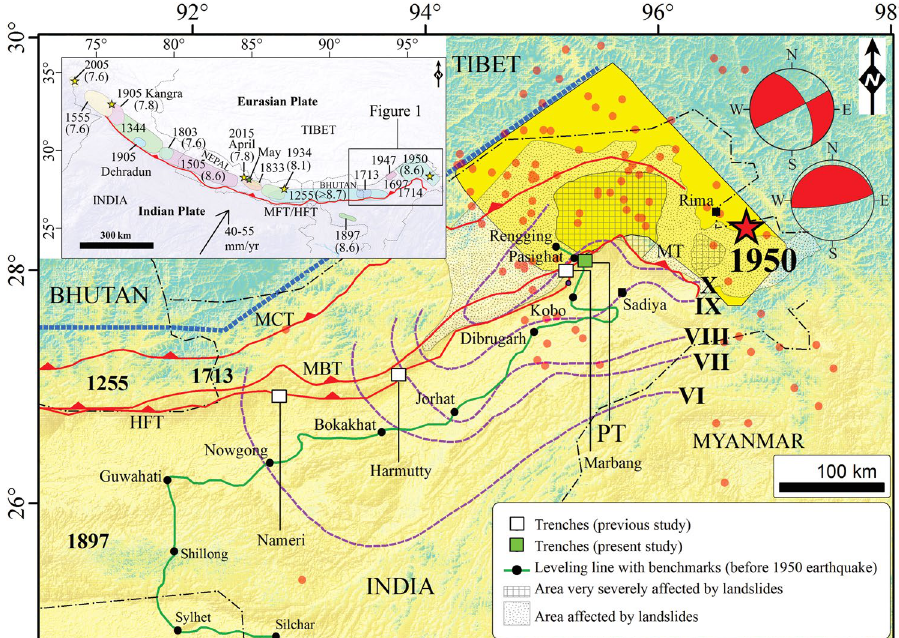
Figure 1. Map showing the historical earthquakes in the eastern Himalaya (1255, 1713, 1897, 1950-yellow polygon). 1950 intensity isoseismals (violet dotted lines denoted by Roman numerals) from previous study 35 . Previous trench locations in the eastern Himalaya (solid white squares) 4, 9 and present study at Pasighat (solid green square); 1950 epicenter (red star) from previous study 15 . 1950 earthquake aftershocks (red dots), locking line at ~3.5 km elevation contour 17 (blue dashed line), co-seismic landslides associated with 1950 earthquake 62 ; leveling line 30 ; international border (thin black dashed-dotted line). ( Inset ) Map showing the rupture zones of large-to-great earthquakes in the Himalaya adopted from previous studies 7, 14, 42 and the convergence rate between India and Eurasia. Maps were prepared in Arc GIS v9.3 using SRTM GTOPO 30 m imagery available at